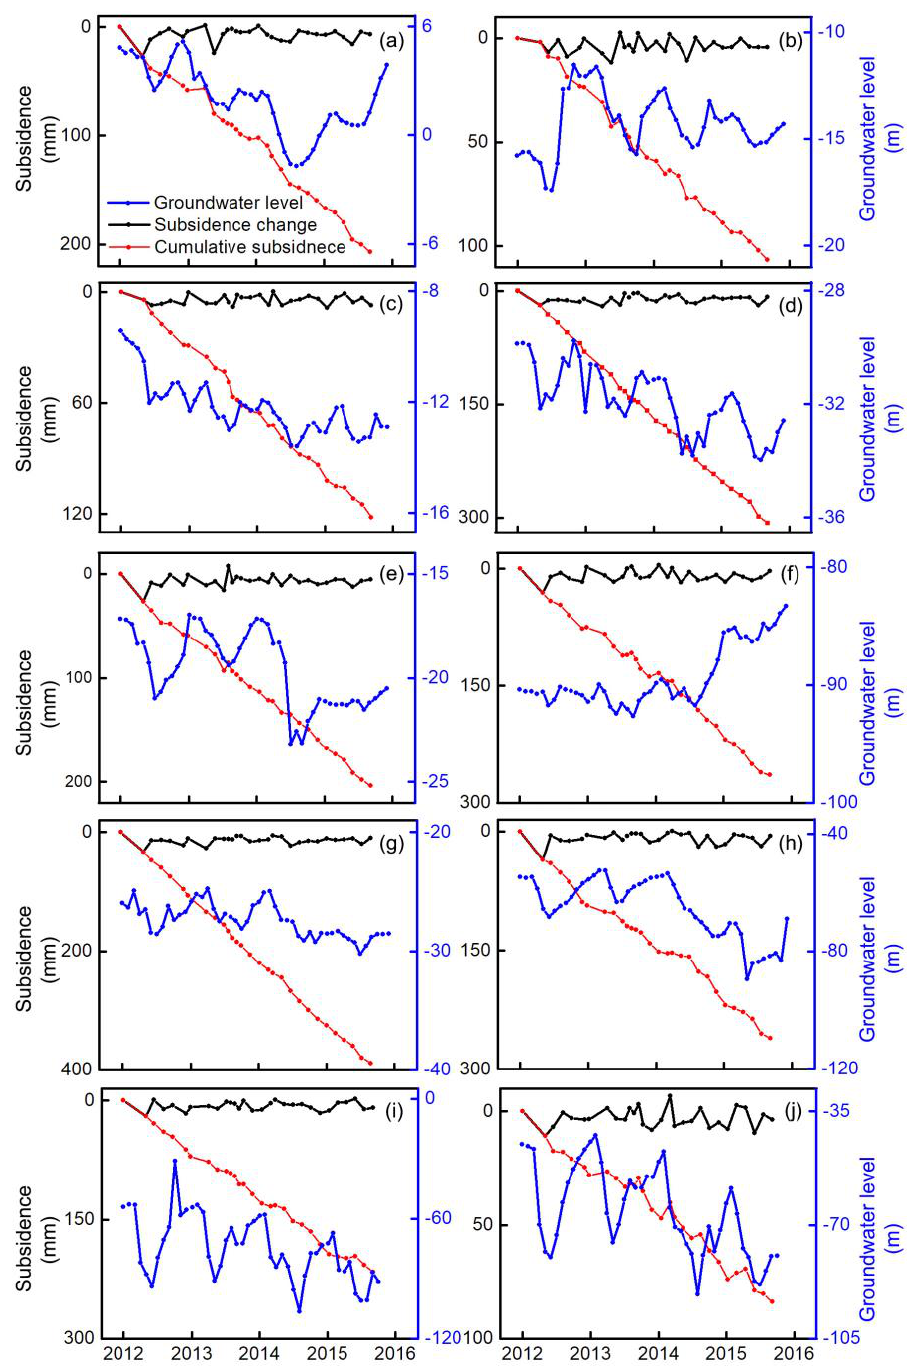
Figure 14. Comparison between subsidence changes and groundwater levels in di ff erent groundwater monitoring wells. ( a – j ) The corresponding subsidence features from ( a ) to ( j ), which were previously discussed. The locations of the groundwater monitoring wells are shown in Figure